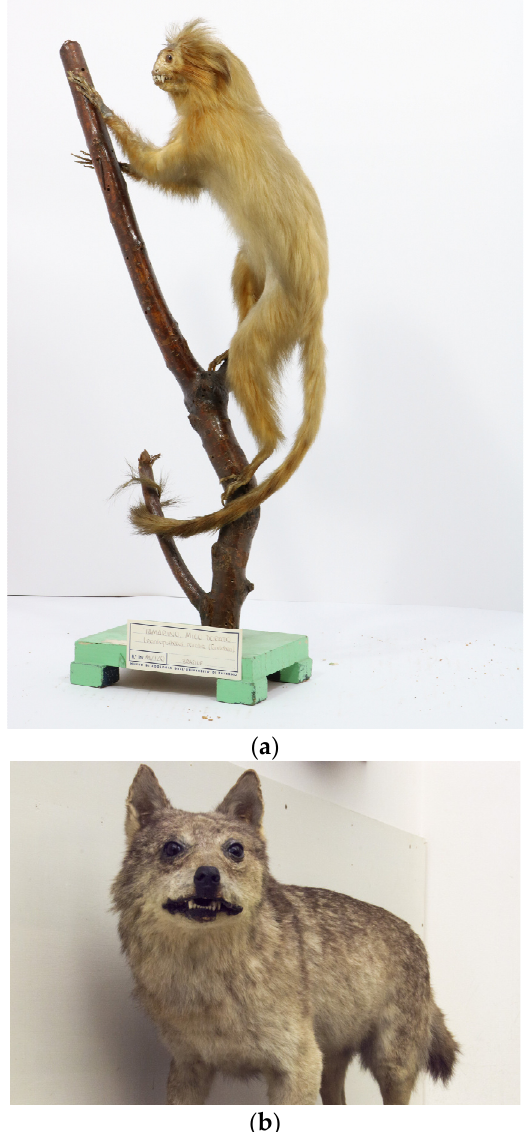
Figure 1. Some characteristic specimens of the Mammal collection at the Museum of Zoology “P. Doderlein”, University of Palermo, Italy. The stuffed and mounted Golden lion tamarin Leontopithecus rosalia ( a ) and Sicilian wolf Canis lupus cristaldii ( b ) from the original nucleus of the Doderlein era.